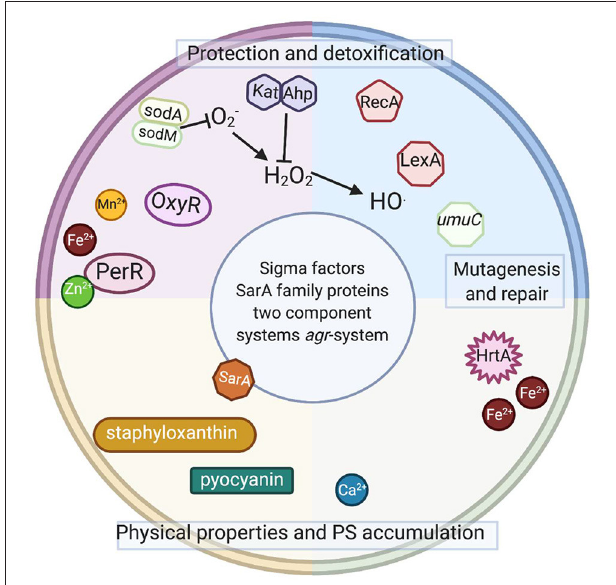
FIGURE 3 | Intracellular elements involved or potentially involved in photodynamic inactivation. Schematic representation of intracellular elements that were studied with respect of photodynamic inactivation of bacteria. Sod, superoxide dismutase; OxyR, PerR, peroxide-responsive regulators in gram-positive and gram-negative species; Kat, catalase in gram-positive and gram-negative species; Ahp, alkyl hydroperoxide reductase in gram-positive and gram-negative species; RecA, recombinase A; LexA, SOS system repressor, umuC , gene coding for an error-prone polymerase in gram-positive and gram-negative species; HrtA, heme-regulated transporter A in S. aureus ; SarA, transcriptional regulator in S. aureus ; agr, virulence accessory gene regulator in S. aureus . Staphyloxanthin (membrane embedded) and pyocyanin (secreted) are dyes produced by S. aureus and P. aeruginosa . Please see the text for detailed explanations (Created with